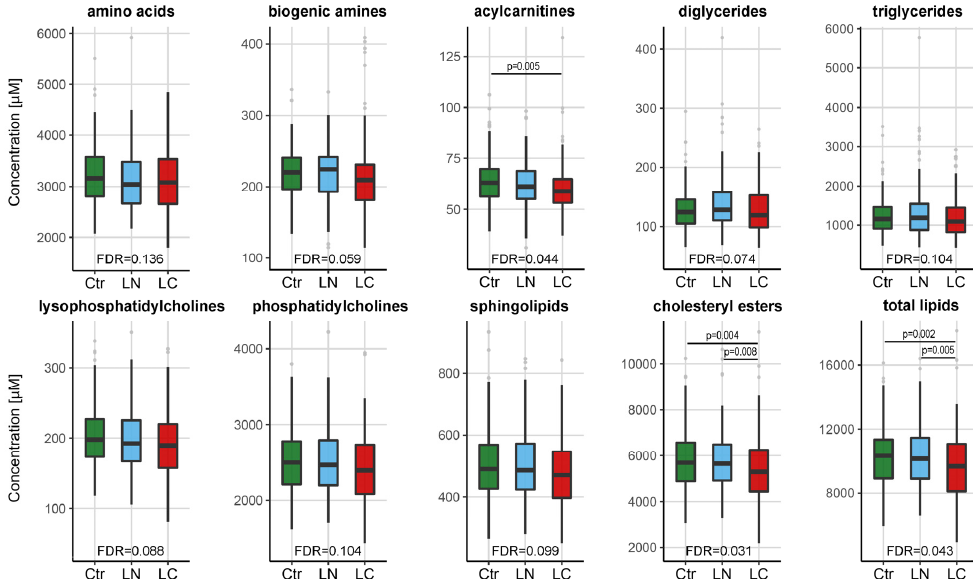
Figure 2. Aggregated concentrations of different classes of metabolites in serum samples of healthy controls (Ctr), individuals with benign lung nodules (LN), and lung cancer patients (LC). Boxplots show the minimum and maximum values, lower and upper quartile, and median (outliers are marked with gray circles); represented are FDR-corrected results of the Kruskal − Wallis test for a general variance and the posthoc test p -values for a significance of differences between pairwise compared groups ( n = 154 in each